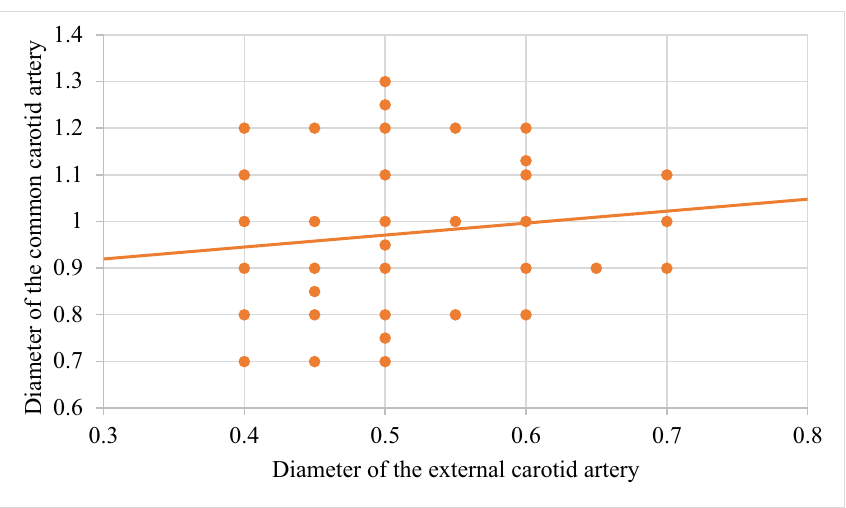
Figure 5. Correlation between the diameters of the common carotid artery and the external carotid